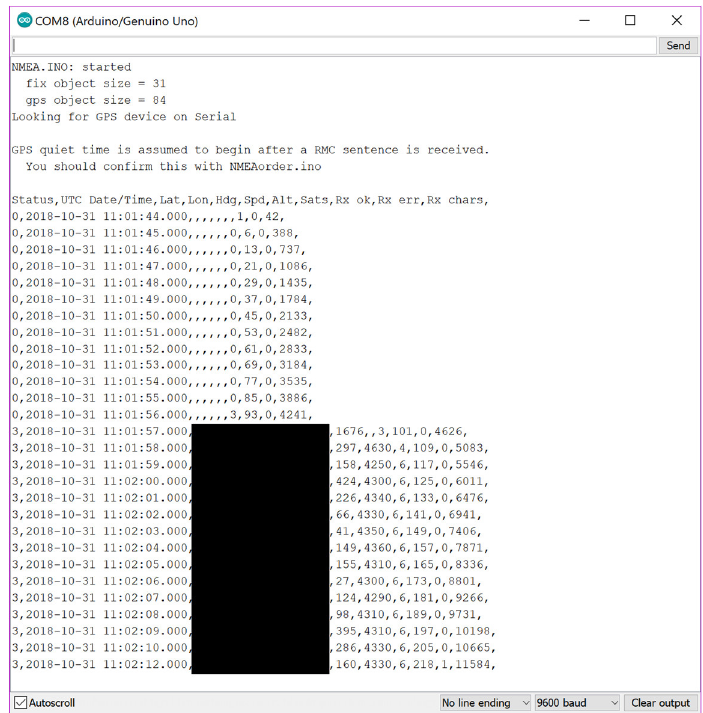
Figure 15. Screenshot of the Serial Monitor showing the output of the NMEA example with redacted GPS coordinates. GPS